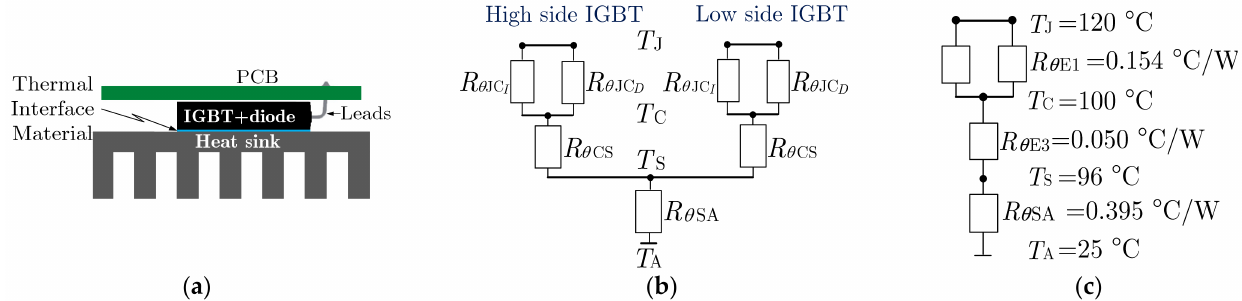
Figure 10. ( a ) IGBT+diode on the heat sink; ( b ) thermal resistance circuit and ( c ) parameters of the thermal